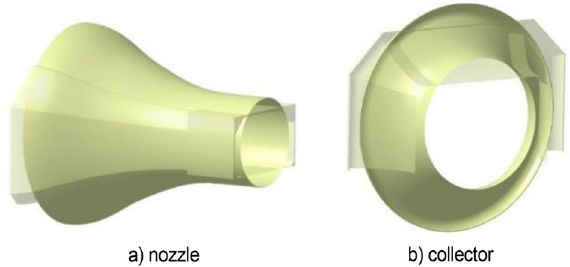
Figure 17. Comparison of some part of the wind tunnel (transparent structure is the original model).